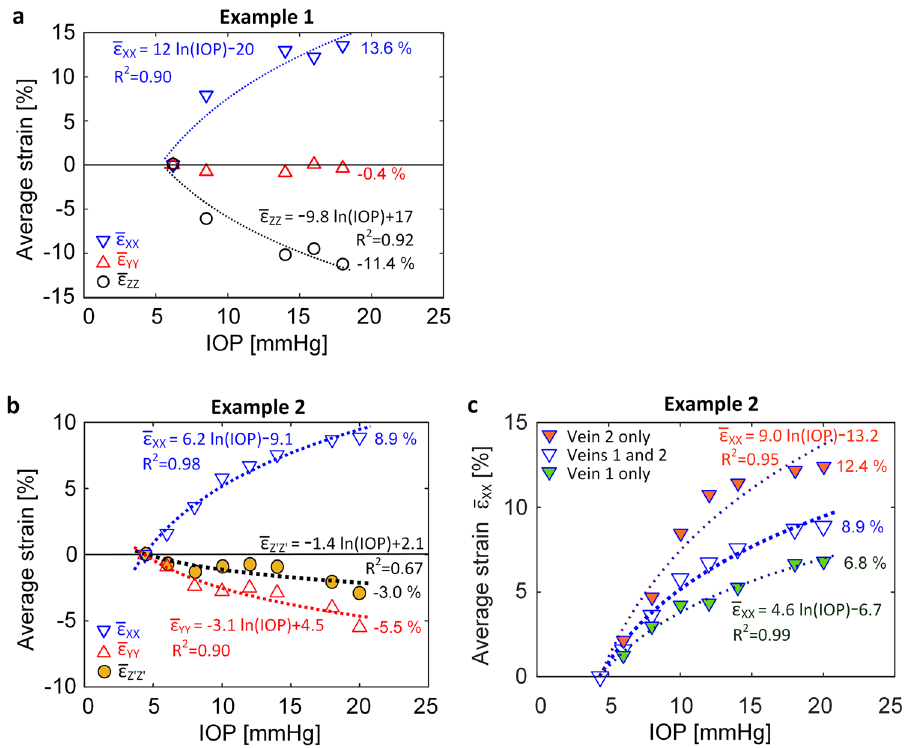
Figure 5. Spatial averages of the aqueous vein strain components, weighted by element volume, as functions of IOP. ( a ) Example 1 (Fig. 2) and ( b )–( c ) Example 2 (Figs. 3 and 4). In ( b ), the averages were computed over the combined regions of aqueous veins 1 and 2. In ( c ), ε XX was determined separately over the regions of vein